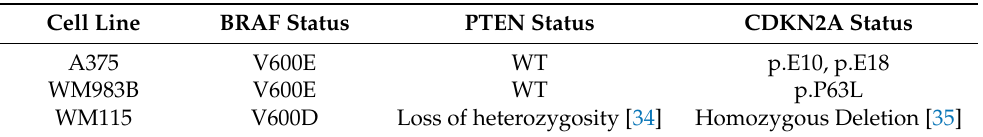
Table 1. BRAF, PTEN, and CDKN2A status in A375, WM983B, and WM115 BRAF-mutant melanoma cell lines